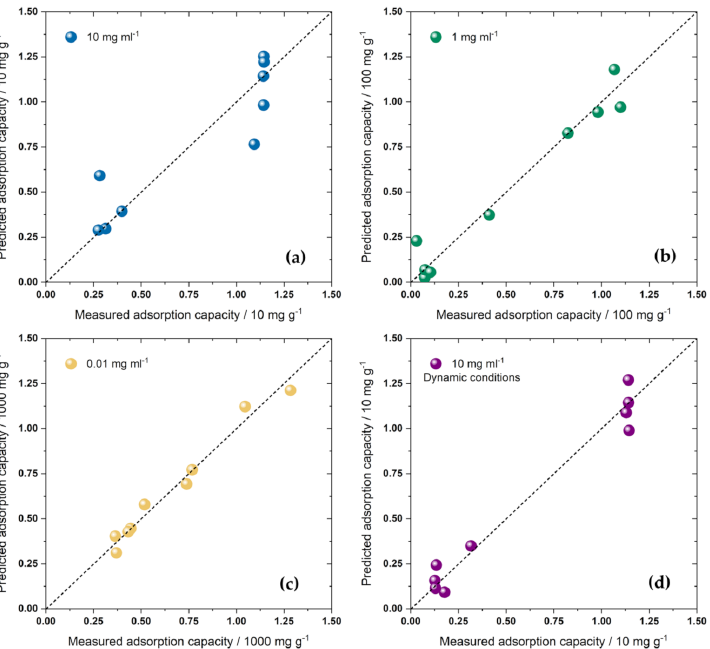
Figure 4. The results of the multiple linear regression model for adsorption capacities determined for adsorbent doses of 10 mg mL − 1 (( a ) R 2 = 0.89), 1 mg mL − 1 (( b ) R 2 = 0.95), 0.01 mg mL − 1 (( c ) R 2 = 0.99), and 10 mg mL − 1 under dynamic adsorption conditions (( d ) R 2 = 0.96). Uncertainties for experimental points are omitted for brevity. They did not exceed 8% of the measured